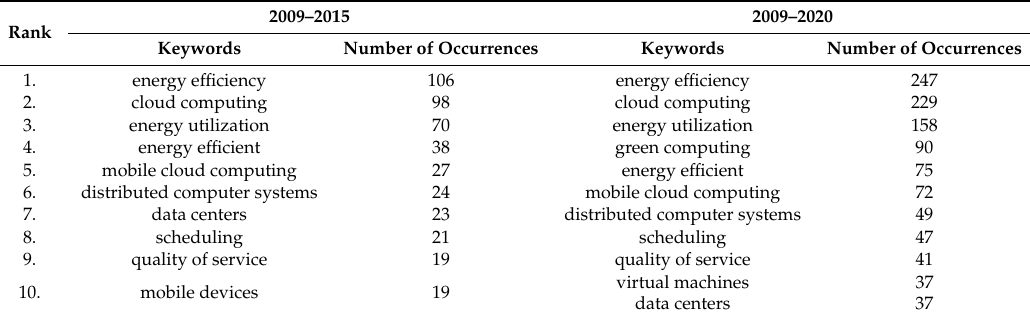
distributed computer